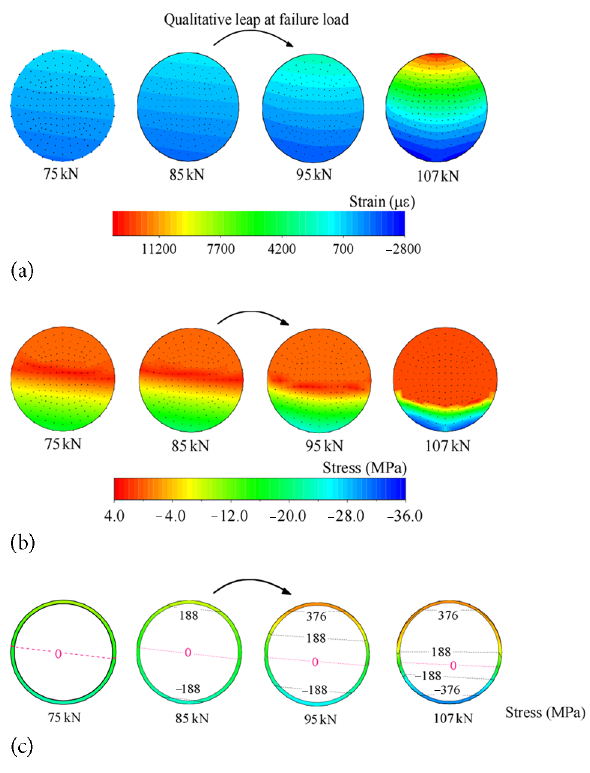
Figure 10. The contour maps of strain/stress fields on section 4: a – strain field; b – stress field of concrete;